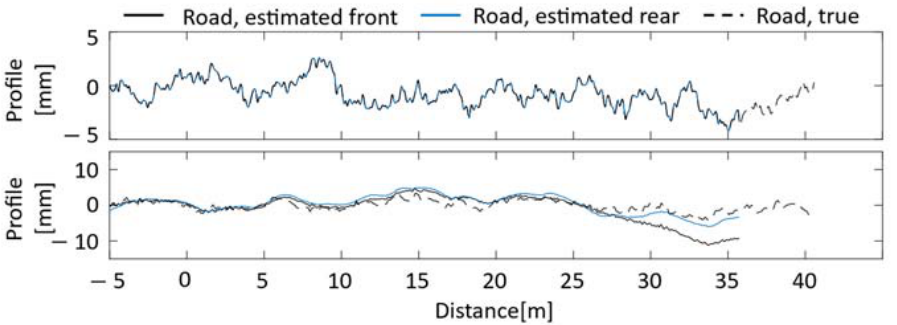
Figure 3. Road unevenness estimation results without Kalman filter [upper: without noise, lower: with noise].